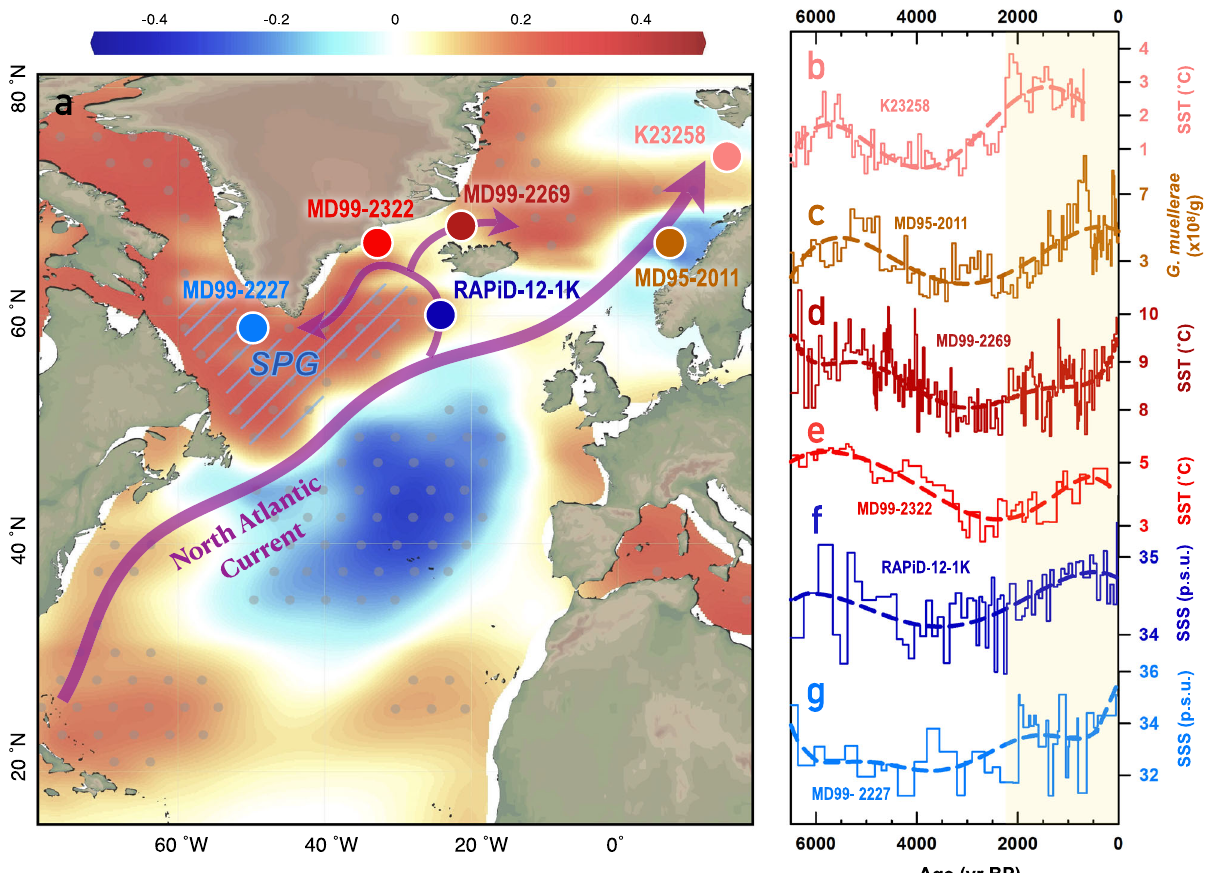
Fig. 3 | Atlantic sea-surface conditions in the last 6500 years. a The North Atlantic Current (purple arrows) and the locations of cited records (white-edged circles).Reb/blue areasshow the inverse correlation coef fi cients between700-mb height pressure variations in the eastern Atlantic (52°30 ’ N, 27°30 ’ W) and sea- surface temperatures (SST) from a 300-year preindustrial controlled Community Earth System Model 2 (CESM2; Methods) 66 . Dotted regions indicate that the cor- relations are signi fi cant at the 95% con fi dence level. Blue slashed region denotes the location of the Subpolar Gyre (SPG). Map was generated using Ocean Data